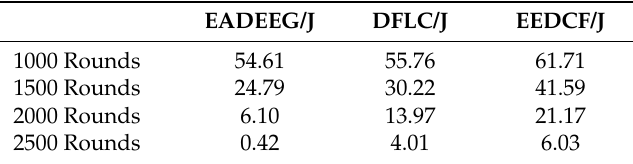
Table 7. System residual energy in Scenario 2.